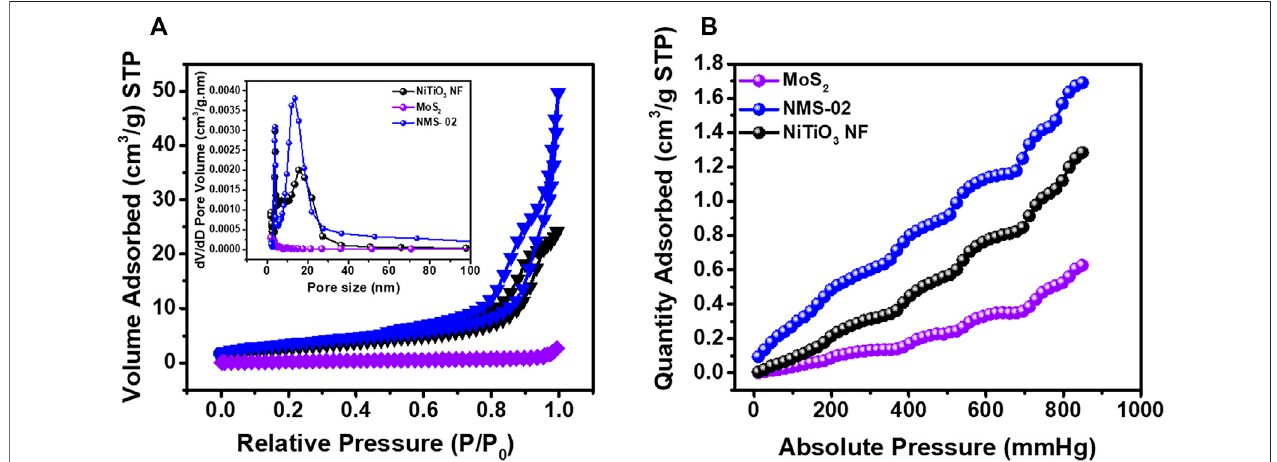
FIGURE 7 | Photocatalytic CO 2 reduction performance of as-prepared samples. (A) Yields of the gases produced. (B) Comparison of CO 2 selectivity among the samples (C) Stability test results of the optimum sample (NMS-02).) (D) XRD analysis of NMS-02 after the stability test.